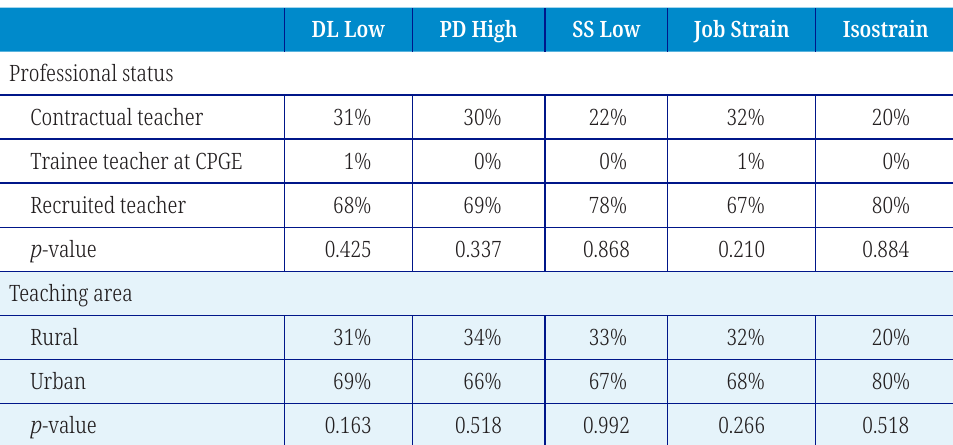
Table 8. Distribution of studied population according to professional status, teaching area and psycho-organizational dimensions (N =